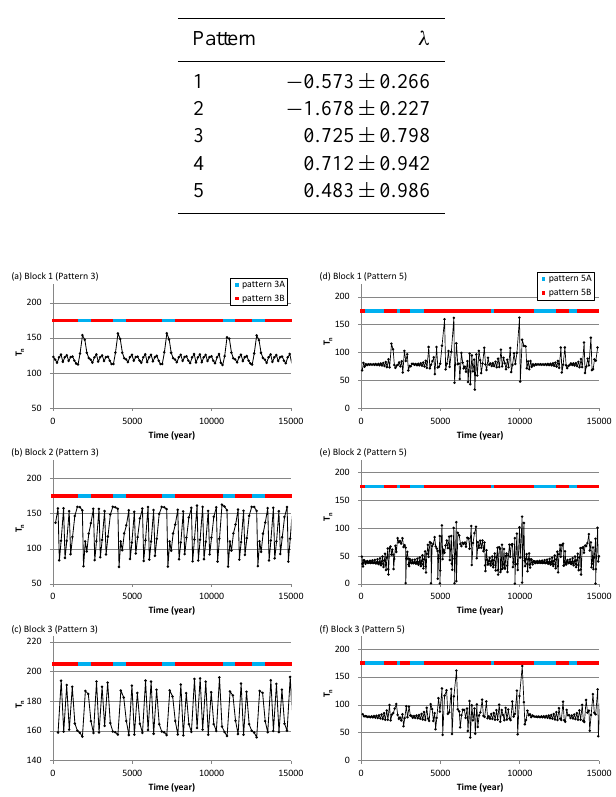
Figure 16. Frequencies of durations longer than τ for patterns (a) 3B, (b) 5A, and (c) 5B. The model parameters for patterns 3 and 5 are the same as those for Figs. 10 and 13, respectively. bars in Fig. 17, are correlated with the change in λ . During a period of pattern 3A, λ decreases from positive to negative, then increases from the local minimum value, and at the same time the slip pattern changes to pattern 3B. In pattern 3B, λ increases to become positive, and is nearly constant for a cer- tain duration. The slip pattern abruptly changes to 3A without any precursor. Figure 17b indicates that pattern 5A is charac- terized by negative values of λ . In each period of pattern 5A, λ gradually increases with time, which corresponds to the fluctuation of T n increasing with time (Fig. 14d). In contrast, the fluctuation of λ during pattern 5B is variable, as shown in Fig. 17b, and any change to pattern 5A is therefore diffi- cult to predict. Although we show only two example cases of the correlation between λ and changes in slip pattern in patterns 3 and 5, similar correlations are observed for other cases with different parameter sets in patterns 3 and